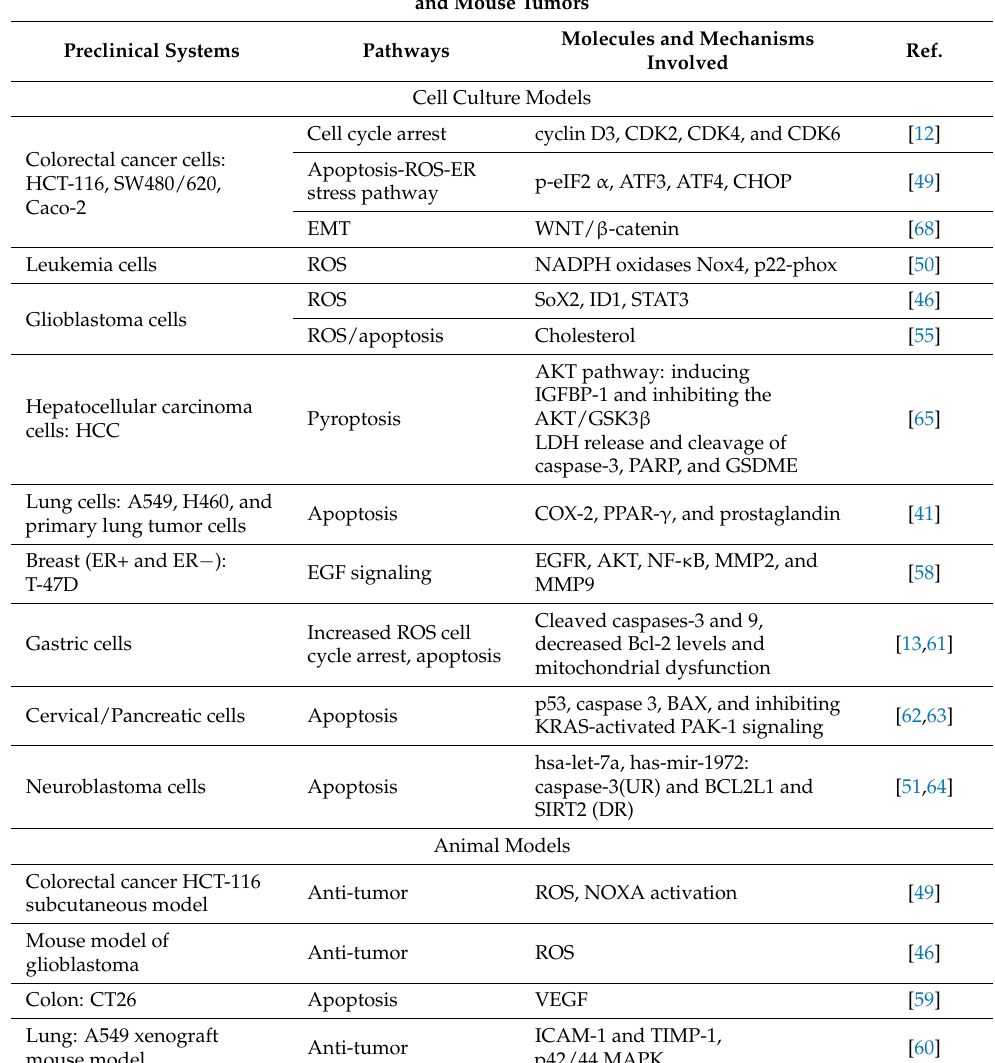
Table 1. Preclinical studies of CBD in cancer. Summary of Preclinical Studies Involving CBD Treatment of Cancer Cells and Mouse Tumors Preclinical